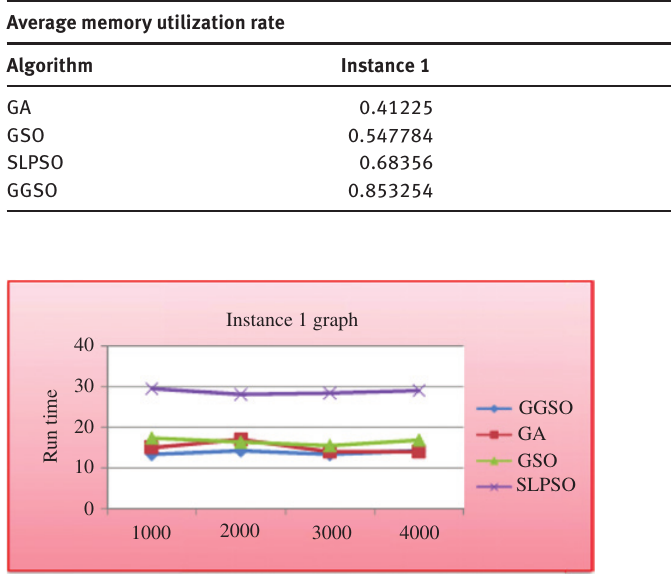
Figure 6: Runtime Performance of Instance 1.